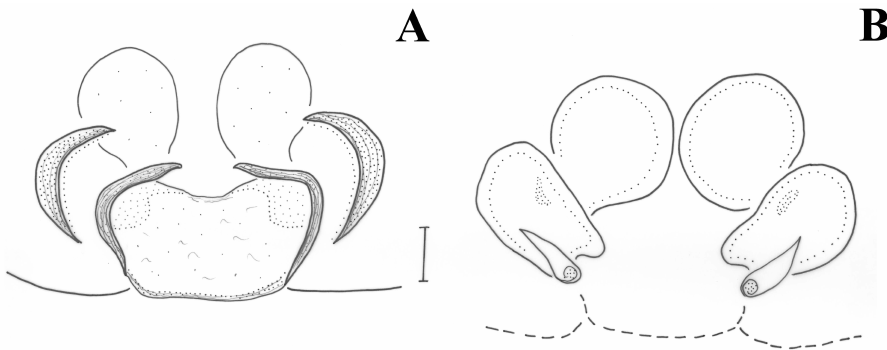
Figure 4. Drassodes omalosis , female (FC: 8792). ( A ) Epigyne, ( B ) vulva.